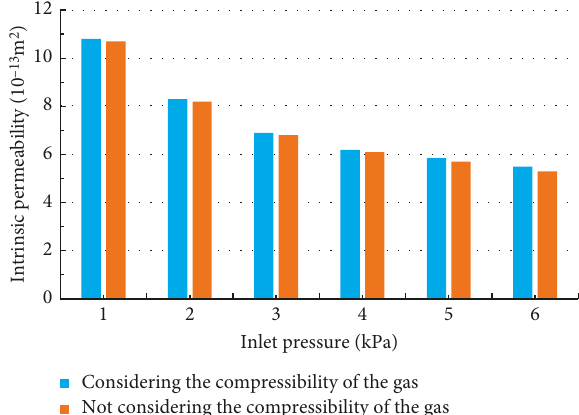
Figure 6: Permeability contrast of different models.